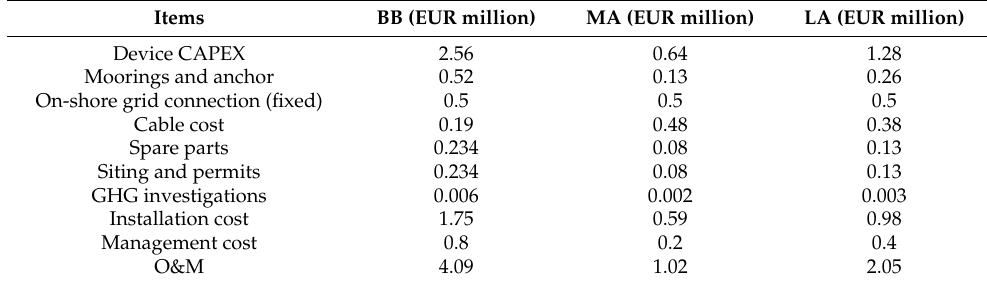
Table 8. Original cost data in the testing